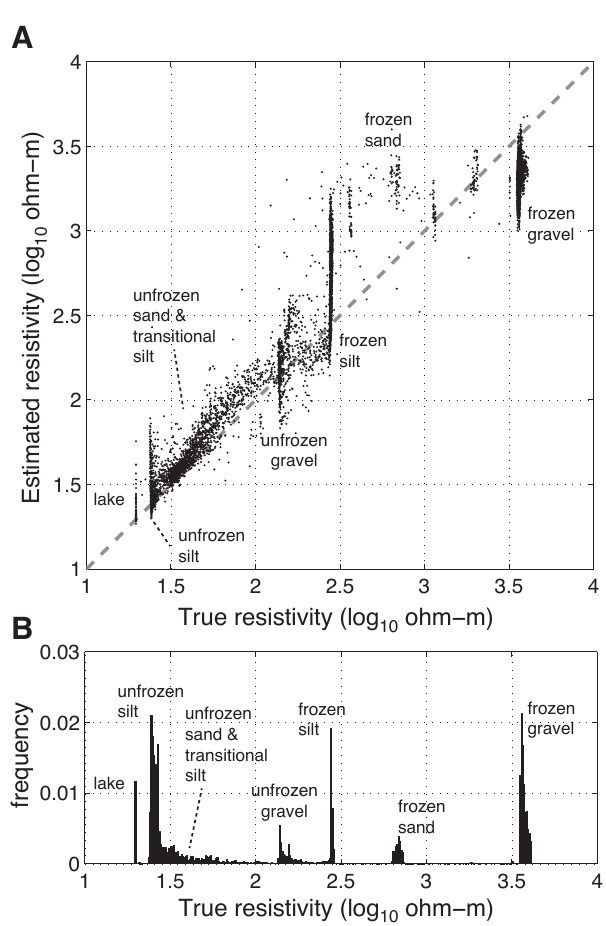
Figure 6. Performance of geophysical parameter estimation in re- covering true parameter values. (a) True versus McMC-estimated resistivity values for the hydrostatic 6m deep lake scenario at simu- lation time 1000 years compared with the frequency distribution of true resistivity values (b) . Estimated resistivity values generally fall along the dashed 1 : 1 line in (a) , with the exception of underpredic- tion of the resistive frozen gravels, overprediction of the thin surfi- cial frozen sand, and some overprediction of the frozen silt where it is in contact with frozen gravel.